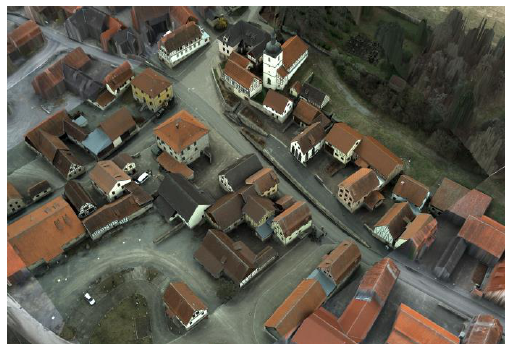
Figure 11. Texturised surface model by using vertical and oblique image